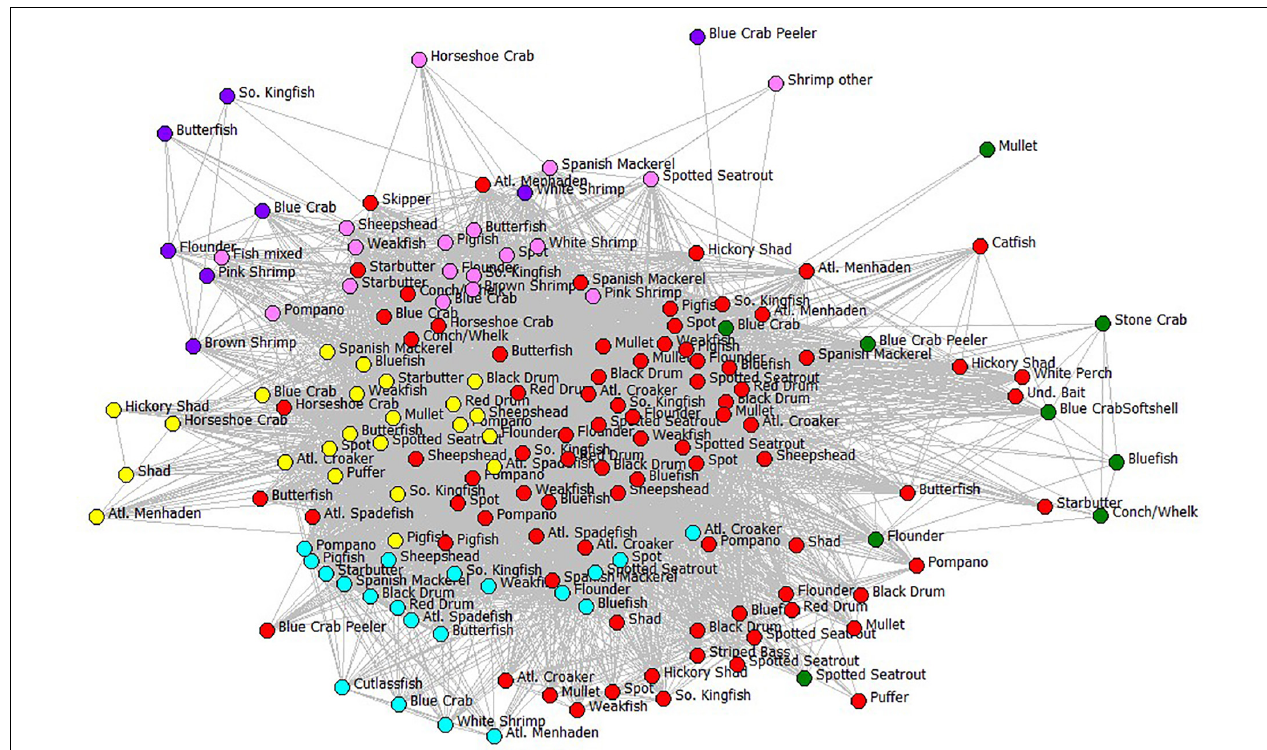
FIGURE 7 | The fisher behavioral network of Core Sound. For clarity, only gear types and species (compartments) used in the ECOPATH model are shown. Each node is a fishery, defined as participant-reported gear type used to catch the species. Edges are switching pathways among fisheries, showing the connection between gear-species fisheries and indicating that at least one fisher was jointly involved in the two fisheries; nodes are color-coded by gear type. Gear codes: cyan = haul seines; pink = shrimp trawls; purple = skimmer trawls; yellow = pound nets; red = gill nets; green = crab pots. Links between nodes represent affiliations, that is, the number of fishers that have those two gear-species combinations in common (gear type-species nodes). The fishery nodes with greatest joint fisher participation were displayed using Fruchterman-Reingold spring-embedder algorithm (Fruchterman and Reingold, 1991). The fishery nodes with high degree centrality (greatest number of joint participants) are in the center in the